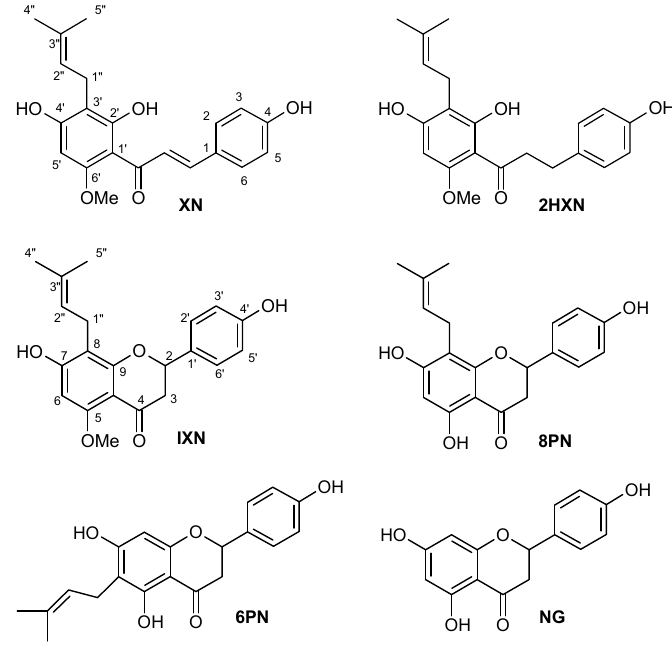
Figure 1. Chemical structures of tested flavonoids.